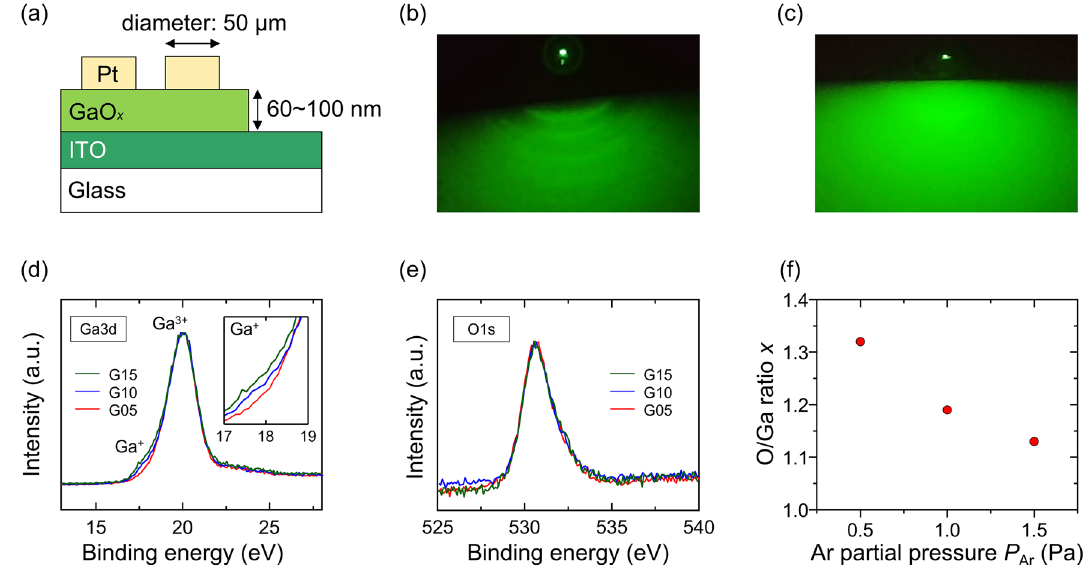
Figure 1. ( a ) Cross-sectional schematic of fabricated Pt/GaO x /ITO memristor. RHEED patterns of surfaces of ( b ) ITO and ( c ) post-deposition Sample G05. XPS spectra of ( d ) Ga3d and ( e ) O1s, and ( f ) the O/Ga ratio as a function of P Ar during